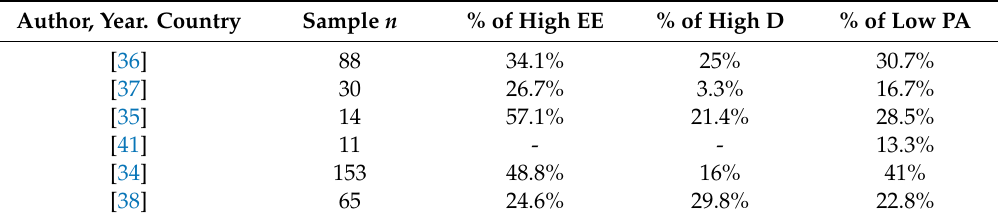
Table 1. Prevalence of high emotional exhaustion (EE), high depersonalisation (D) and low personal accomplishment (PA).